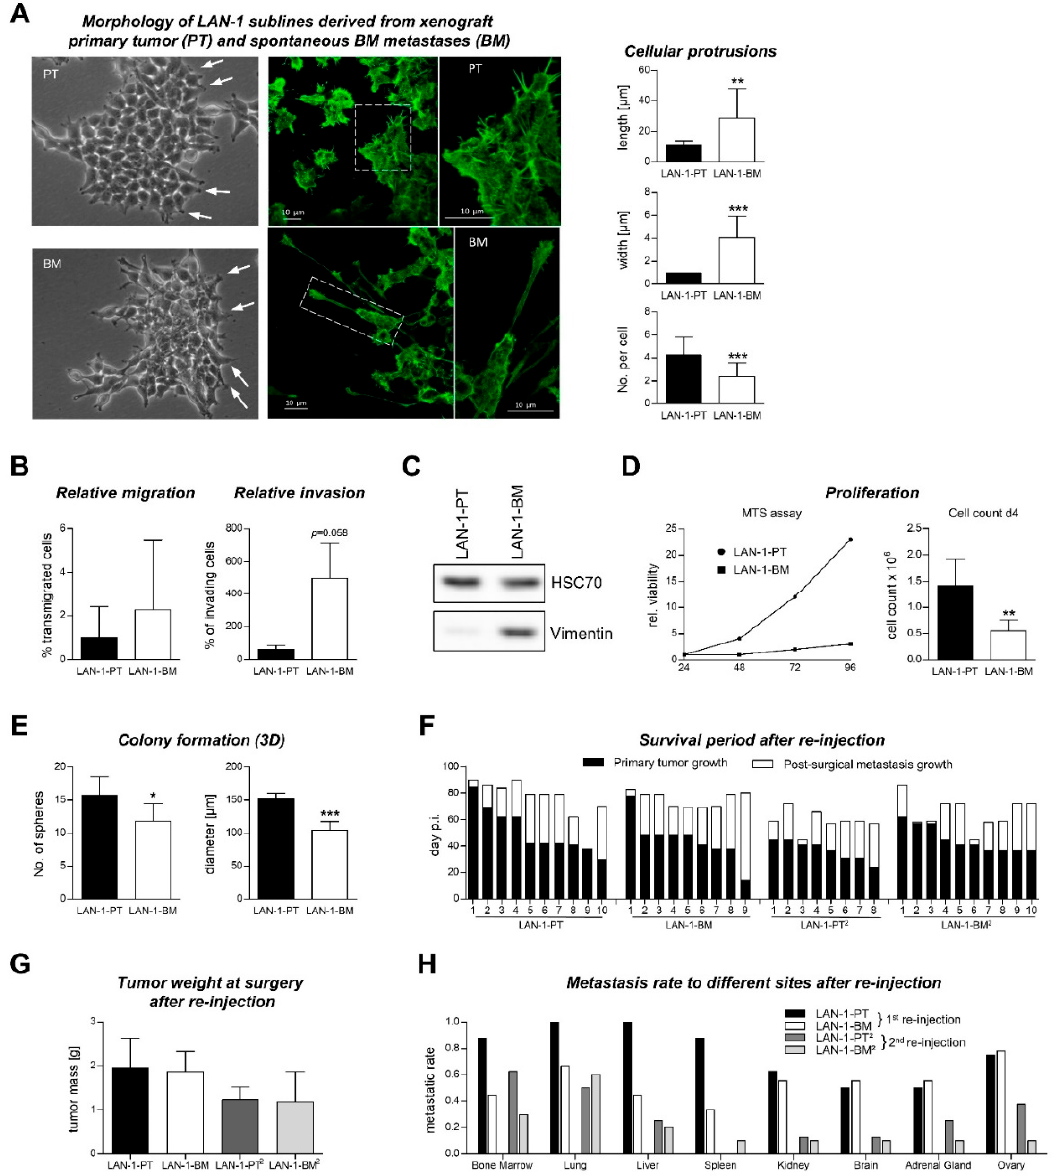
Figure 4. Characterization of LAN-1 cells recovered from a xenograft primary tumor (LAN-1-PT) and corresponding spontaneous bone metastasis (LAN-1-BM). ( A ) F-actin immunocytostaining of LAN-1-PT and LAN-1-BM cells analyzed for length, width, and number of filopodia-like protrusions per cell. ( B ) Cell transmigration through a porous membrane was similar between both sublines, while the relative invasive potential was by trend higher in the LAN-1-BM subline. ( C ) LAN-1-BM cells showed a strong increase in vimentin expression. ( D ) Cell viability (MTS assay) and proliferation was decreased in the LAN-1-BM subline. ( E ) Colony formation assays in soft agar showed decreased numbers and diameters of tumor spheres formed by the LAN-1-BM subline. ( F , G ) After re-injection and a second round of re-cultivation and re-injection (of the respective sublines LAN-1-PT 2 and LAN-1-BM 2 ), the pre- and post-surgical survival periods and tumor weights at surgery were quite comparable between the PT / BM and PT 2 / BM 2 groups. ( H ) Unexpectedly, there was no increase, but rather a decrease in the incidence of spontaneous BM metastases in the LAN-1-BM / BM 2 as compared to the LAN-1-PT / PT 2 groups. * p < 0.05, ** p < 0.01, *** p < 0.001.